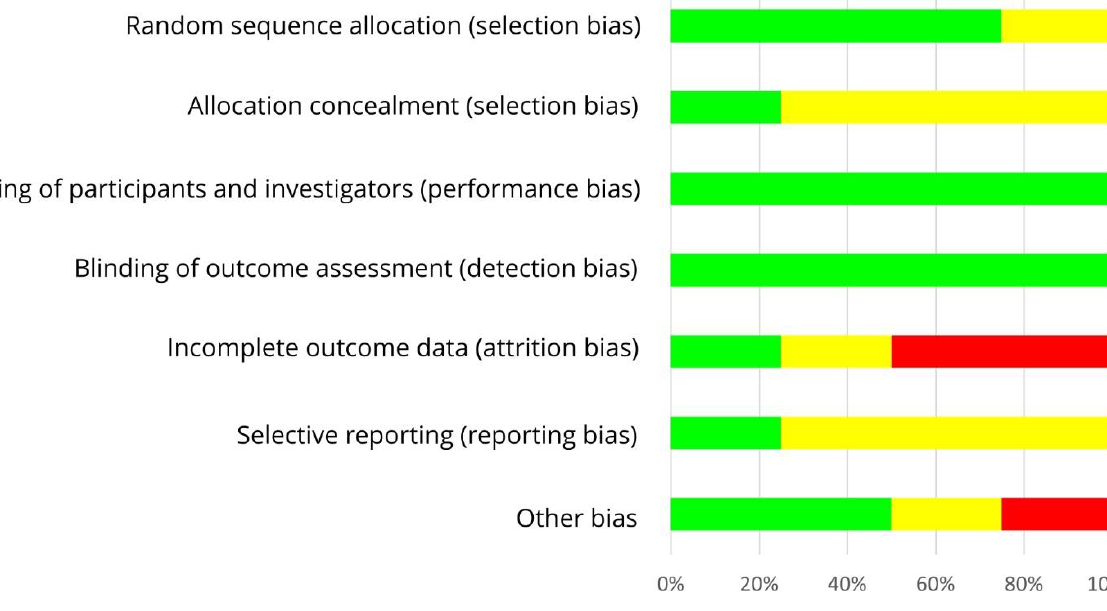
Figure 7. Risk of bias summary across studies with a mixed group of pre-, peri- and postmenopausal women. Green (+), low risk of bias; yellow (?), unclear risk of bias; red (−), high risk of bias .